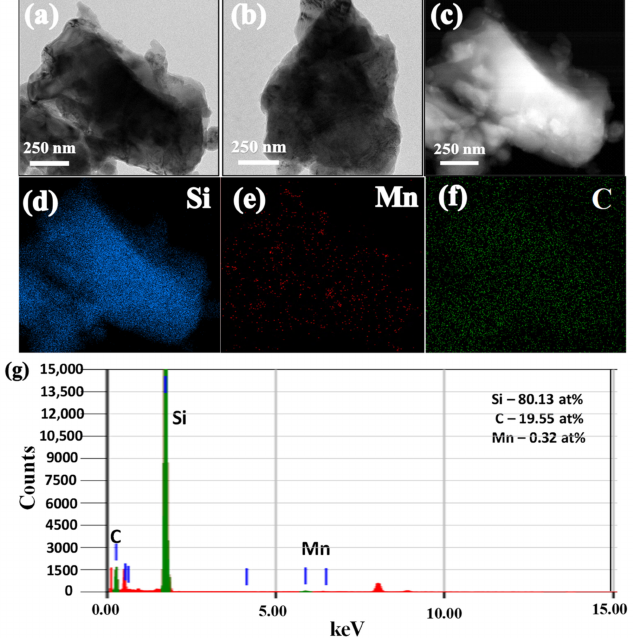
Figure 6. ( a – c ) TEM images; ( d–f ) corresponding EDX elemental mapping of Si, Mn, and C of ( c ); ( g ) TEM-EDX spectra of SiMnG, where green colored lines indicate C, Si and Mn (from left to right), and red colored lines indicate Copper (Cu) from the TEM sample